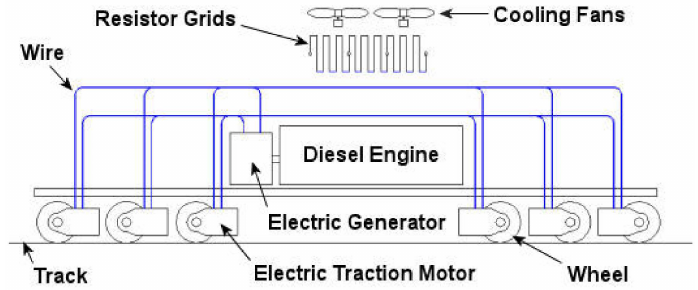
Figure 1. The rheostatic braking process in diesel–electric locomotive [6].